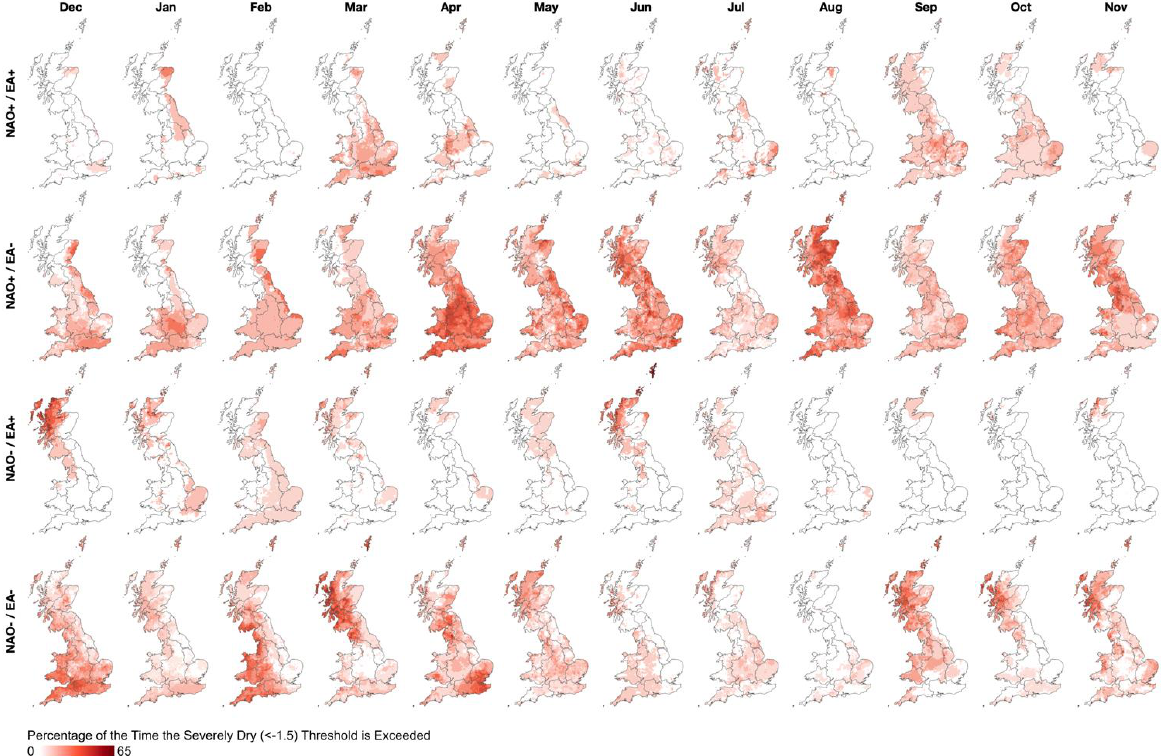
Atmosphere 2021 , 12 , x FOR PEER REVIEW Figure 10. As per Figure 7 but for the severely dry (SPI-1 < − 1.5) SPI-1 class.